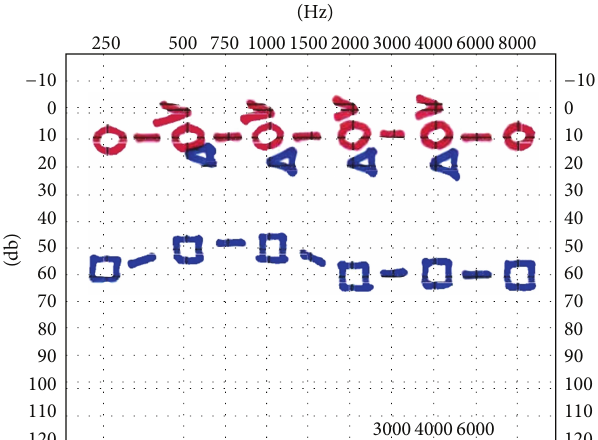
Figure 1: A pure-tone audiometry before surgical treatment shows a moderate, pantonal, conductive hearing loss in the left ear.